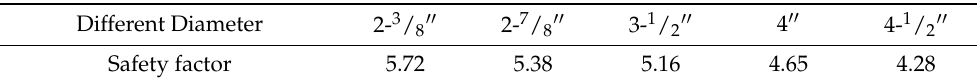
Table 3. Safety factors for different tubing diameters (Uniform pump shutdown time of 6 s and inside pressure of 10 MPa).